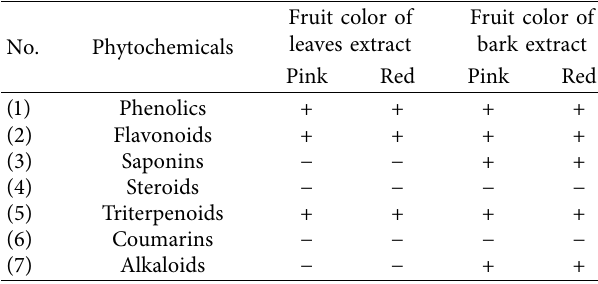
Table 1: Results of phytochemical screening of leaves and stem bark extracts of S . aqueum with pink and red fruits.